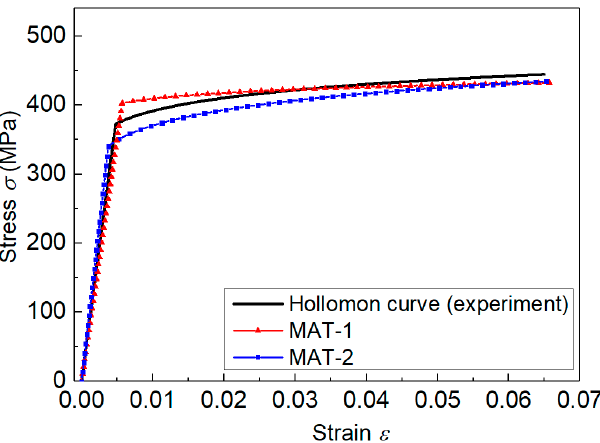
Figure 10. Comparison of stress–strain curves of MAT-1 and MAT-2, with the uniaxial tensile curve.